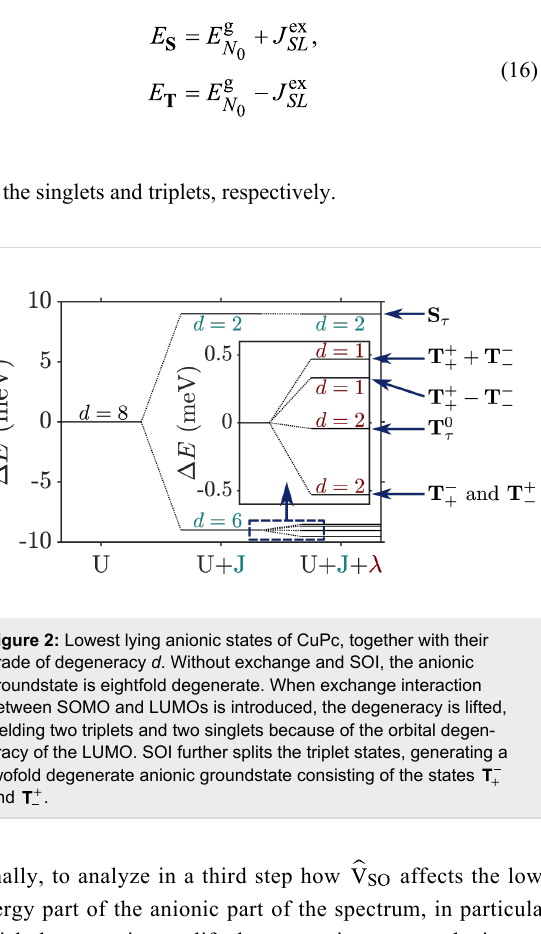
shifts. To this end, some additional states have to be